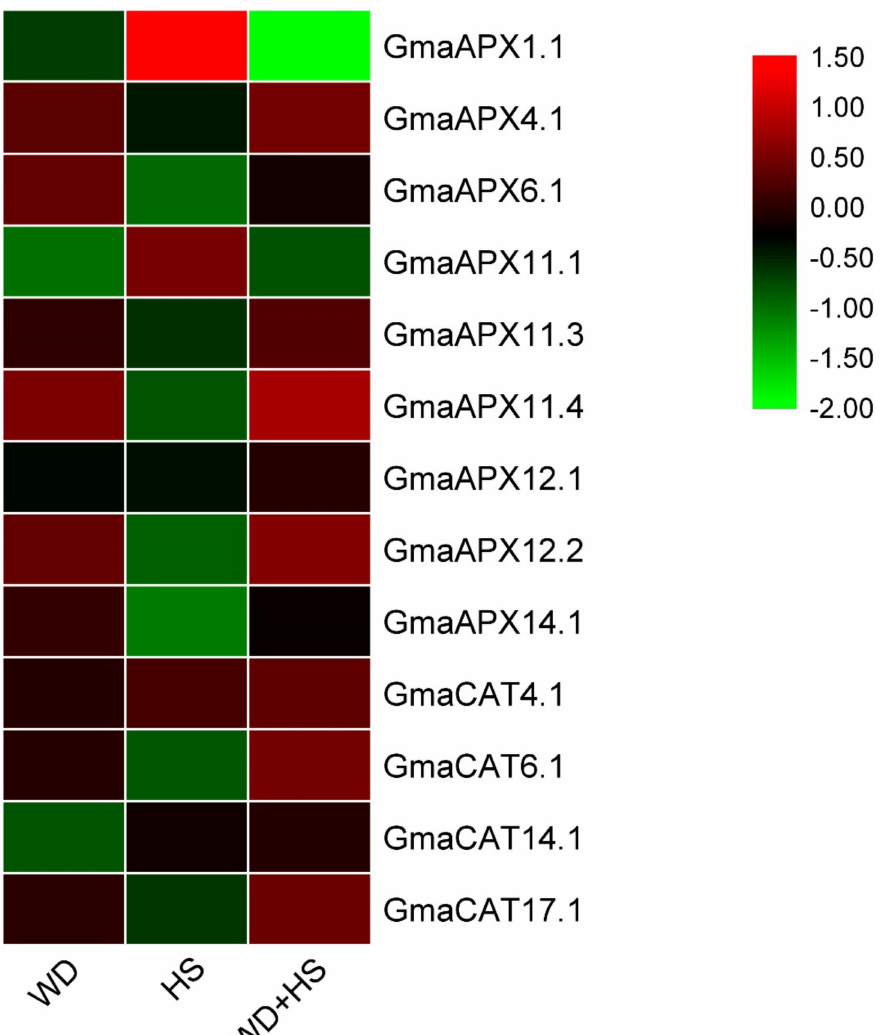
Figure 8. Differential expression of soybean APX and CAT genes under water deficit (WD), heat stress (HS) and combined water deficit and heat stress (WD + HS). These RNA-seq data were previously generated and deposited in the SoyBase database by Shen et al. [56]; the experimental conditions used to generate these RNA-seq data are presented in detail in